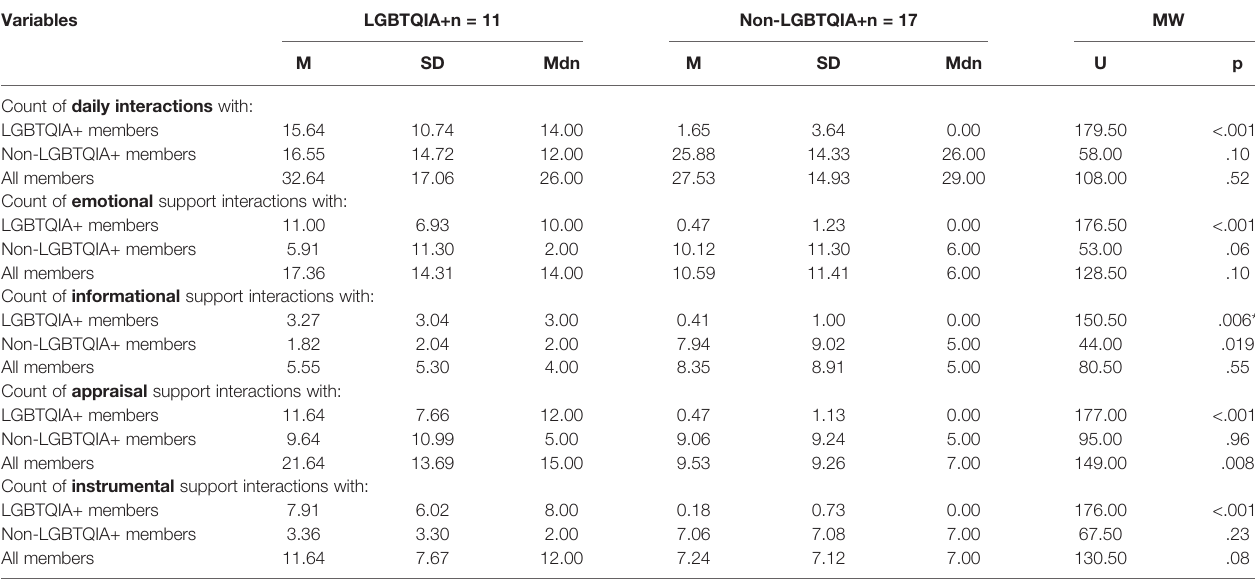
TABLE 4 | Support interactions with LGBTQIA+ and non-LGBTQIA+ network members.